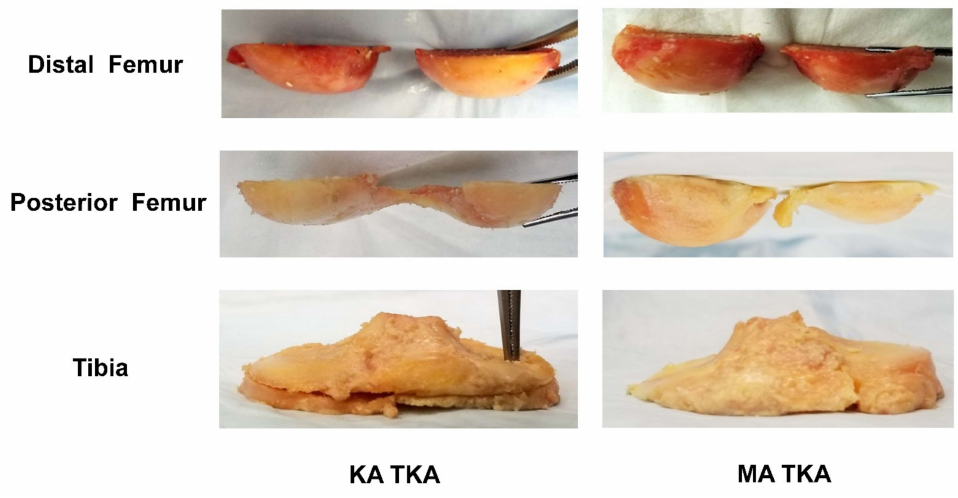
Figure 1. The resected osteochondral fragments. During KA TKA, the femur and tibia resection thicknesses were the same as those of the implants placed in the native joint lines. In the MA TKA group, distal femoral resection was performed perpendicular to the mechanical axis of the femur; the trans-epicondylar axis served as the reference when determining the external rotation of the femoral component. Tibial resection was then performed perpendicular to the mechanical axis of the